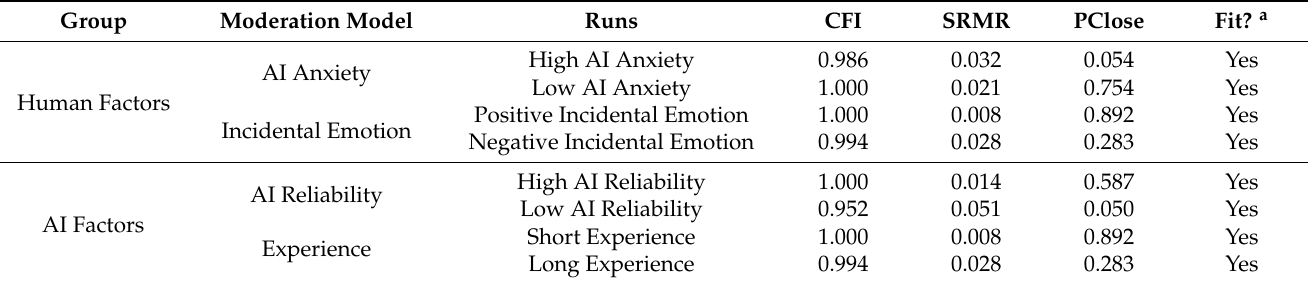
Table 11. Local moderation test fit scores.